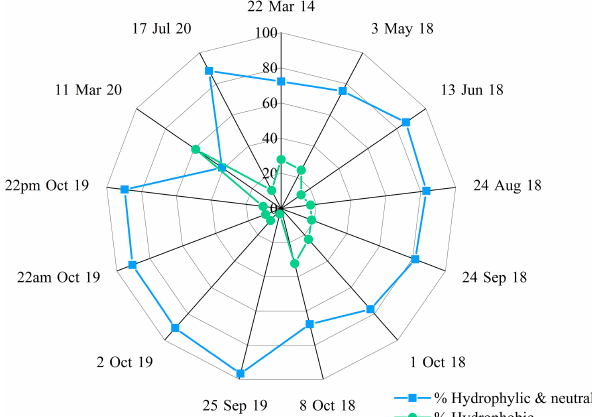
Figure 6. Relative composition of AAs grouped by hygroscopicity (hydrophilic + neutral versus hydrophobic AAs) observed in each cloud